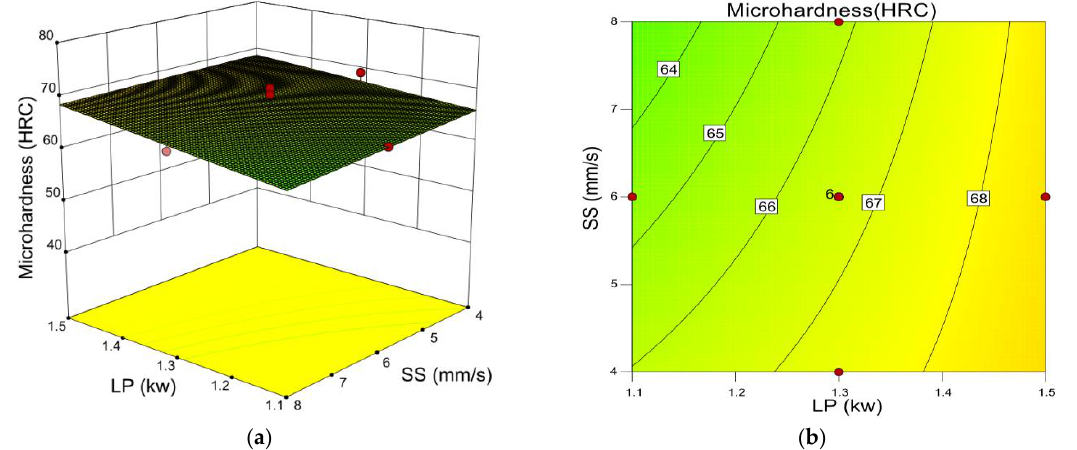
Figure 4. ( a ) 3D influence of laser power and scanning speed on micro-hardness. ( b ) Contour line of laser power and scanning speed on micro-hardness.